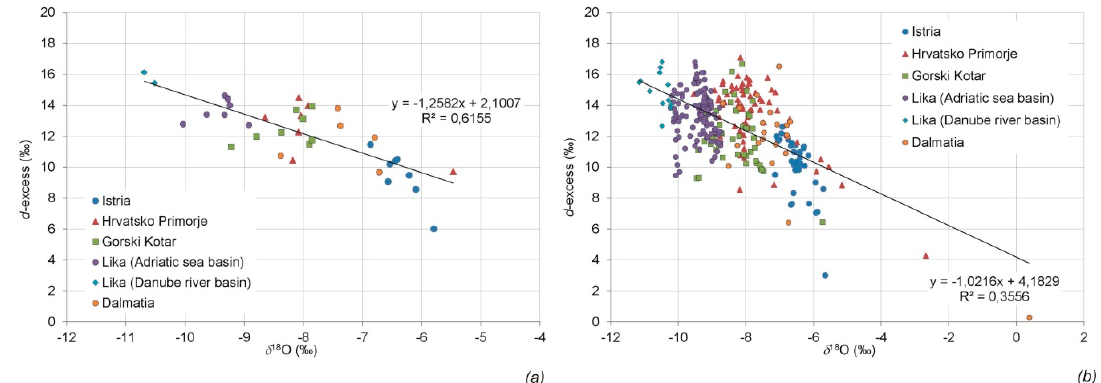
Figure 5. Linear relationship between δ 18 O and d -excess of karst groundwater: ( a ) the mean values and ( b ) the single values.